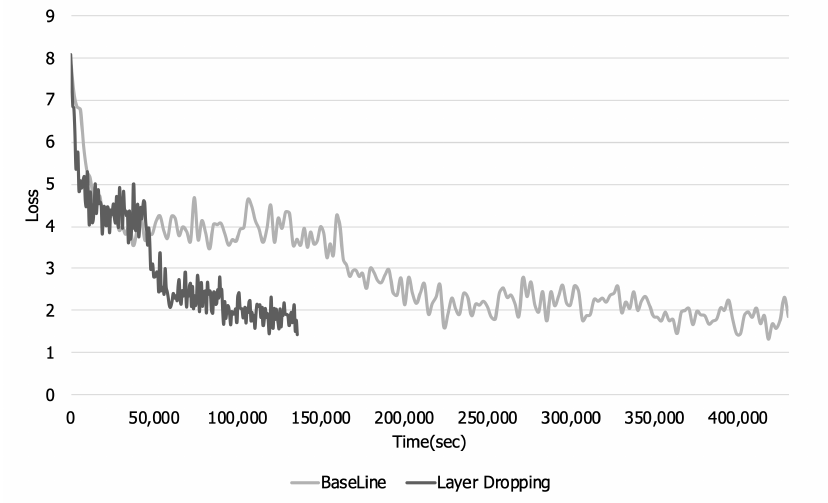
Figure 12. Training loss over time in a high bandwidth network.